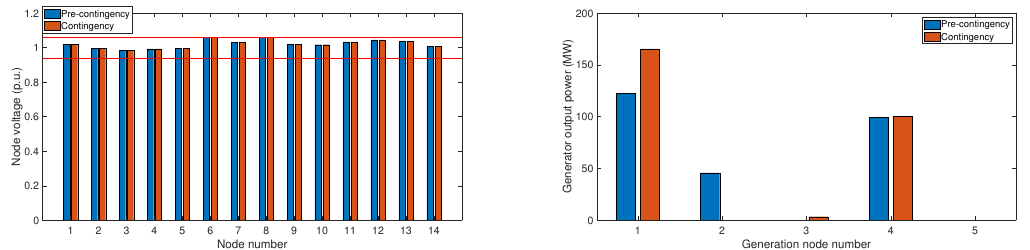
Figure 15. Voltage and power dispatched in the extended power system with PV generation prior to and after contingency of branch 5 (generation nodes are, respectively, nodes 1, 2, 3, 6, and